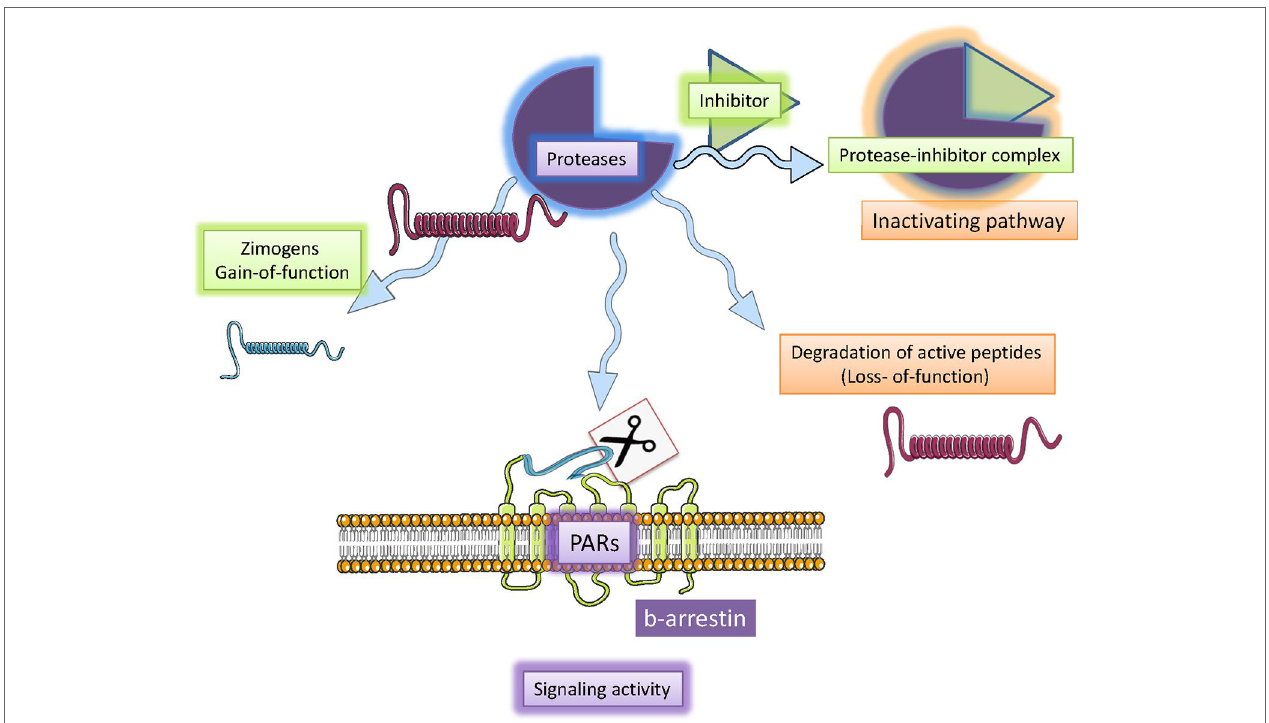
FIGURe 3 | Direct anticoagulants may be thought as indirect PAR inhibitors. Direct anticoagulants including low molecular weight heparins and novel oral anticoagulants (NOAC) have different pharmacokinetic features including the volume of distribution and oral availability but share their ability to inhibit FII and FXa